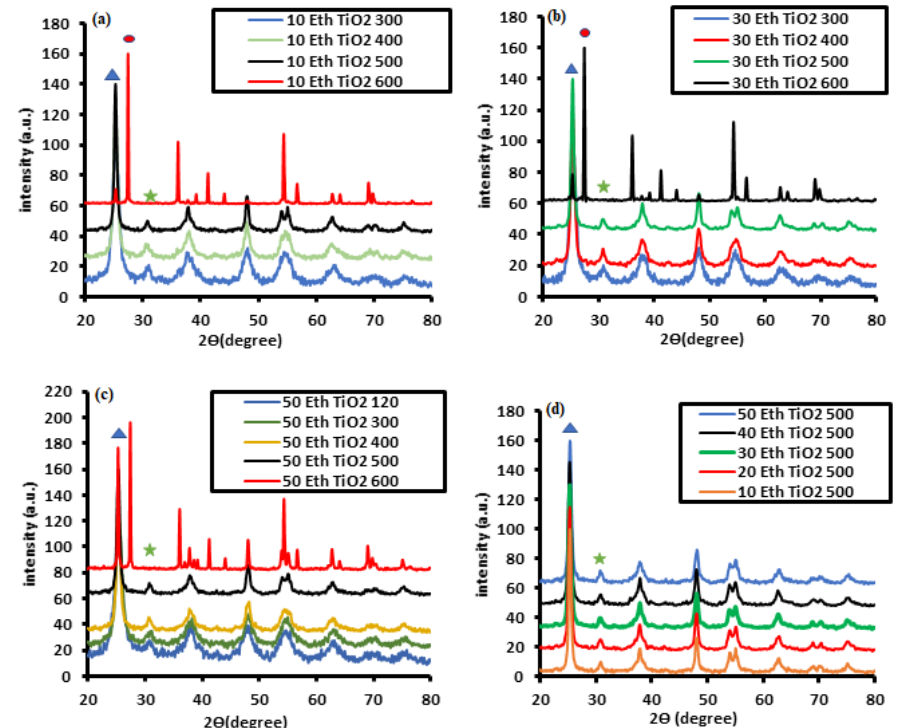
Fig. 1. XRD patterns of TiO prepared with different volumes of ethanol and calcined at different temperatures: (a) 10 mL Eth, (b) 30 2 mL Eth, (c) 50 mL Eth, (d) all Eth volumes at 500 °C (  Anatase phase, ● Rutile Phase,  brookite